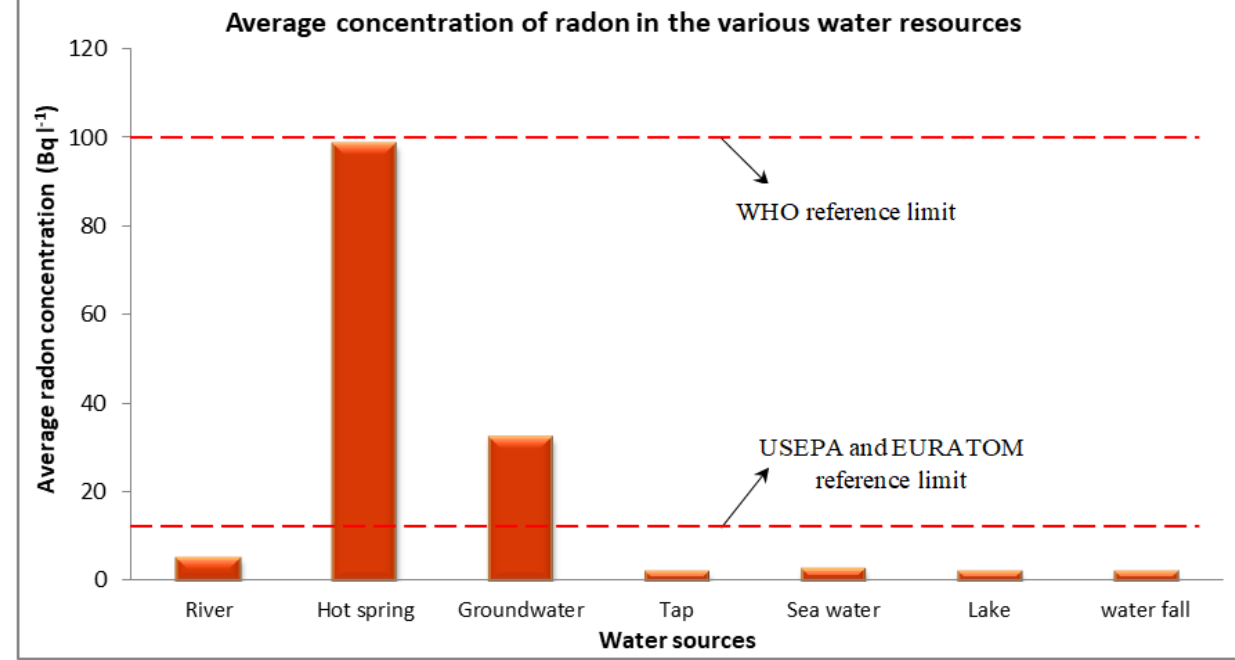
Figure 4. Average radon concentrations in water sources of the southwest coastal region of Peninsular Malaysia.